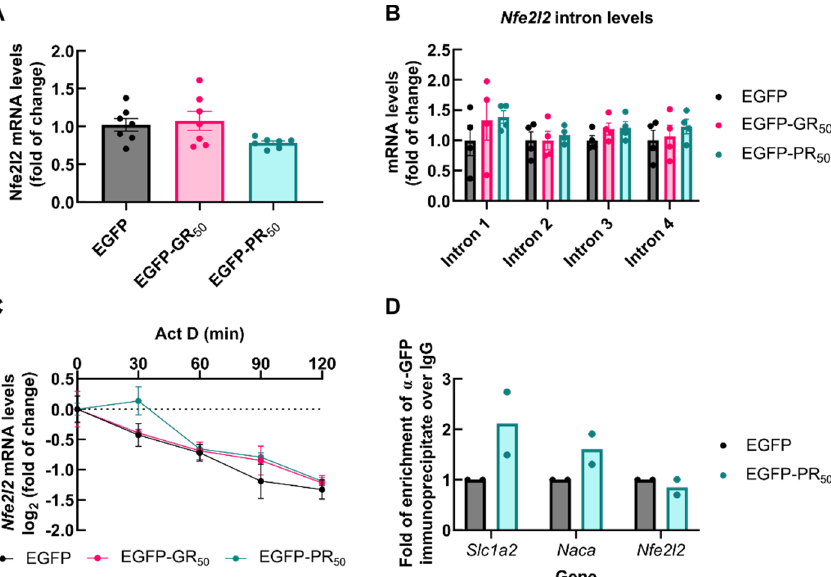
Figure 5. DPRs do not modify Nfe2l2 mRNA levels, splicing, half ‐ life or sequester them. NSC34 cells were transiently transfected with EGFP (control), EGFP ‐ GR 50 or EGFP ‐ PR 50 for 48h. ( A , B ) Nfe2l2 total transcripts levels and intron levels in mRNA were measured by qRT ‐ PCR. ( C ) Transcription was blocked with 5 μ g/mL of actinomycin D in transfected NSC34 cells for the indicated times and mRNA levels for Nfe2l2 were measured by qRT ‐ PCR. ( D ) mRNA levels of the indicated transcripts were measured by qRT ‐ PCR in RNA bound to EGFP ‐ immunocomplexes. In ( A , B ) mRNA levels were normalized by the geometric mean of the housekeeping genes Gapdh , Actb and Tbp. In ( C ) mRNA levels were normalized by the geometric mean of the stable transcripts from Gapdh and Actb . Bar height ( A , B , D ) and point ( C ) indicates the mean of the whole group and error bars indicate the SEM. Statistical analysis was performed with one ‐ way ANOVA for ( A , B ), and two ‐ way ANOVA in ( C ), yielding non ‐ significant changes.